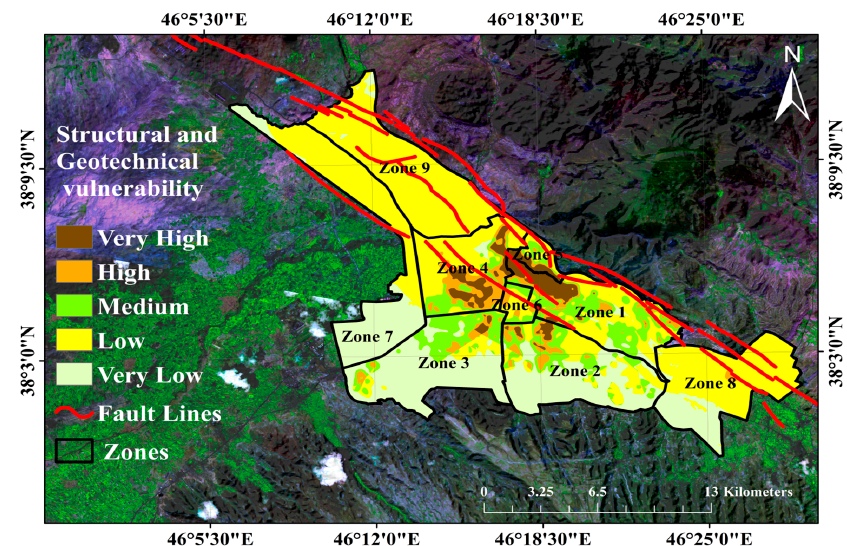
Figure 6. Residential buildings vulnerability distribution showing structural vulnerability in Tabriz municipality.